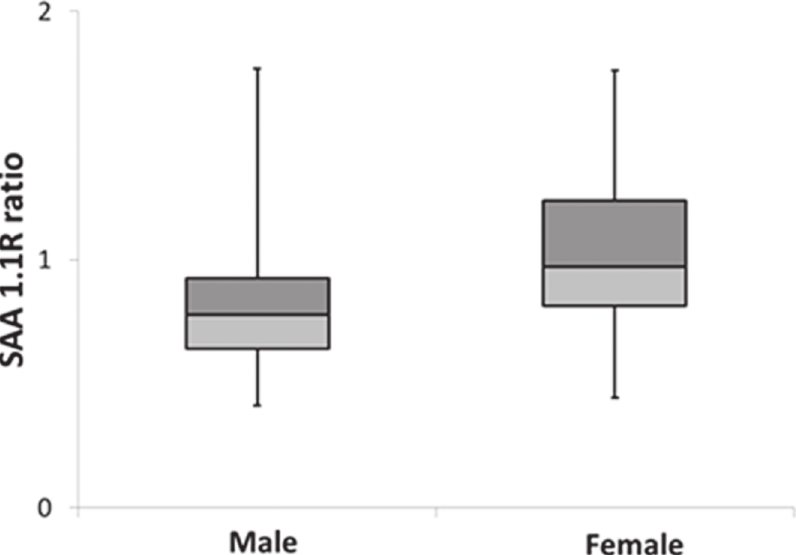
Figure 2. SAA variant ratios (median, IQR) among males (n = 76) and females (n = 84) group. SAA 1.1R (missing N -terminal R arginine) ratio to SAA 1.1 was significantly lower in males compared to females (p <